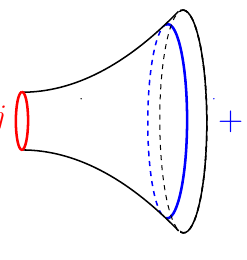
Figure 2: Half-wormhole saddle-point. The + represent the boundary source + ik . At the geodesic boundary, we impose a Dirichlet boundary condition on χ